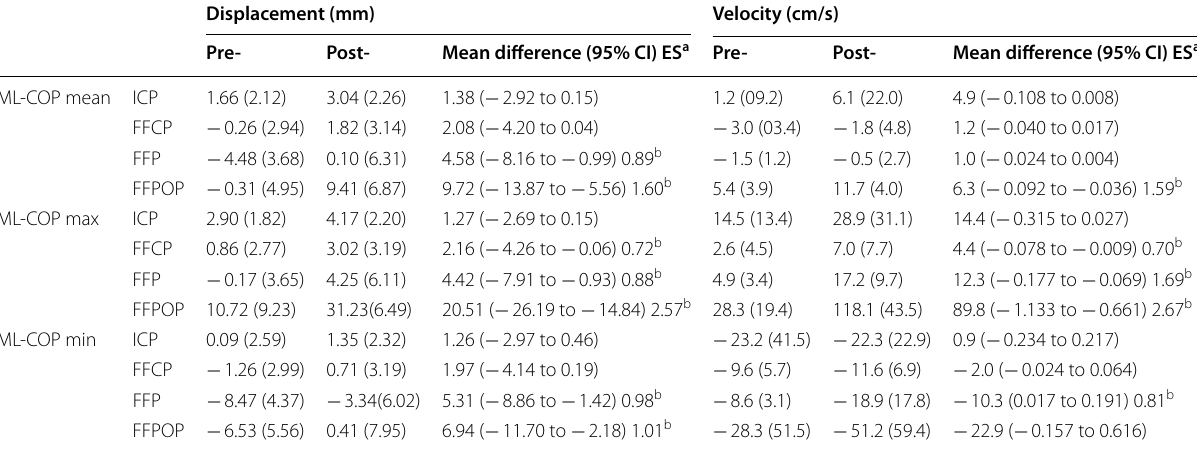
a ES: Effect size (Cohen’s d) only reported for statistically significant comparisons. CI: confidence interval b Significant difference between groups, p <